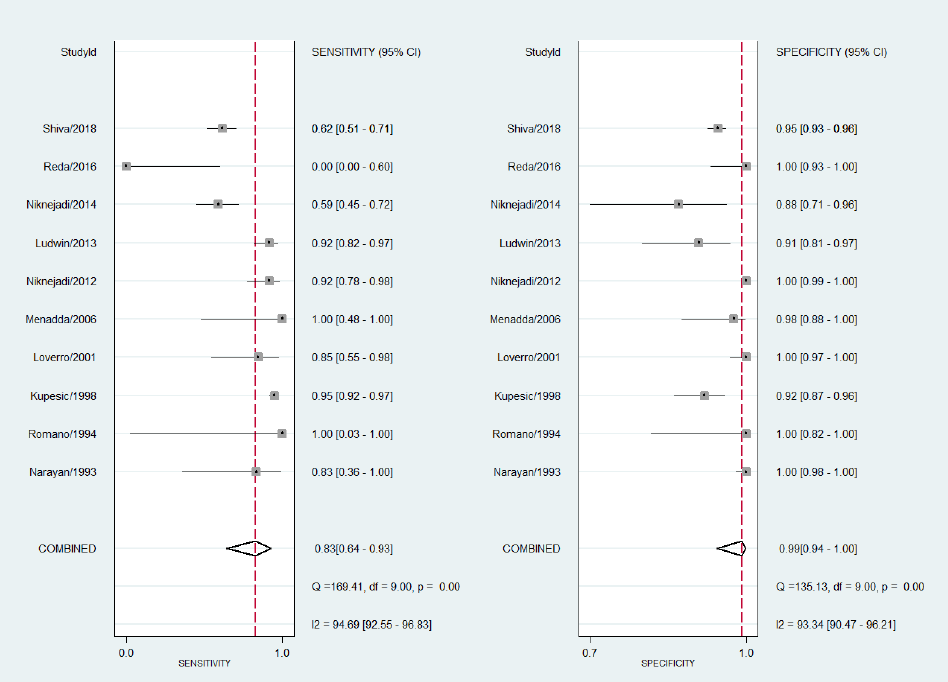
Figure 2. Forest plot for sensitivity and specificity for all studies concerning the diagnostic perfor- mance of two-dimensional transvaginal ultrasonography for uterine septum detection [ 13,22,23,24,26,28,32,34,36,37] .